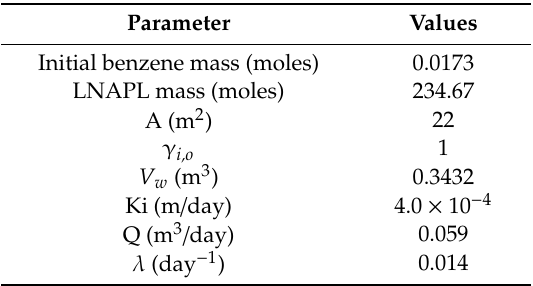
Table 2. Model parameterization of simulations reproducing the BTEX depletion in LNAPL in response to the interphase mass transfer.